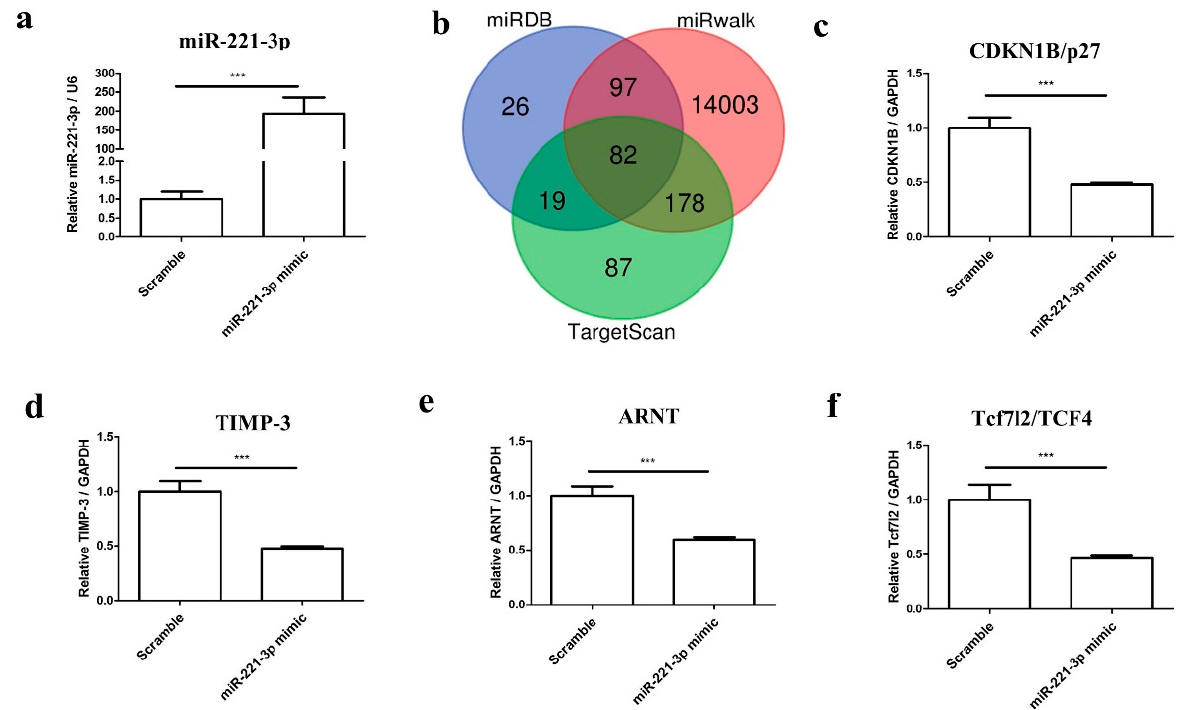
Figure 2. MiR-221-3p was increased by mimic transfection and the targets were predicted and identified in chondrocytes. ( a ) The transfection efficiency of the miR-221-3p mimic was confirmed by RT-qPCR relative to U6. ( b ) Predicted targets of miR-221-3p were identified using three independent platforms, i.e., miRDB, TargetScan, and miRwalk. ( c – f ) Chondrocytes were transfected with miR-scramble and miR-221-3p mimic, while the expression level of predicted targets was measured relative to GAPDH by RT-qPCR and *** p < 0.001 vs. corresponding control. Thereafter, we predicted downstream target mRNAs using the publicly available websites miRDB, miRwalk, and TargetScan (Figure 2b). Given the potential role of miR-221- 3p in chondrocytes and osteoblasts homeostasis as reported in the literature, we chose four possible targets including Cyclin-dependent kinase inhibitor 1B (CDKN1B/p27), Tissue inhibitor of metalloproteinase 3 (TIMP-3), Transcription factor 7-like 2 (Tcf7l2/TCF4),